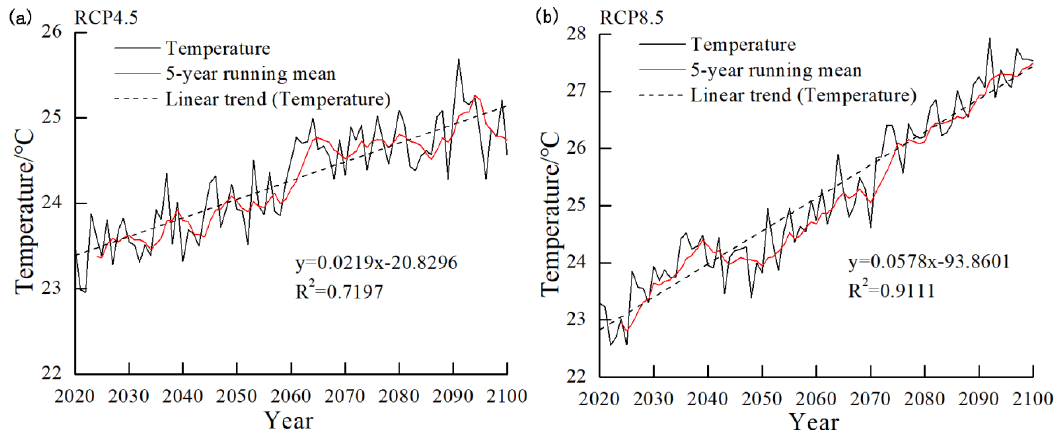
Figure 2. Variation of the annual temperature in the Lancang-Mekong sub-region under the RCP4.5 ( a ) and the RCP8.5 ( b ).